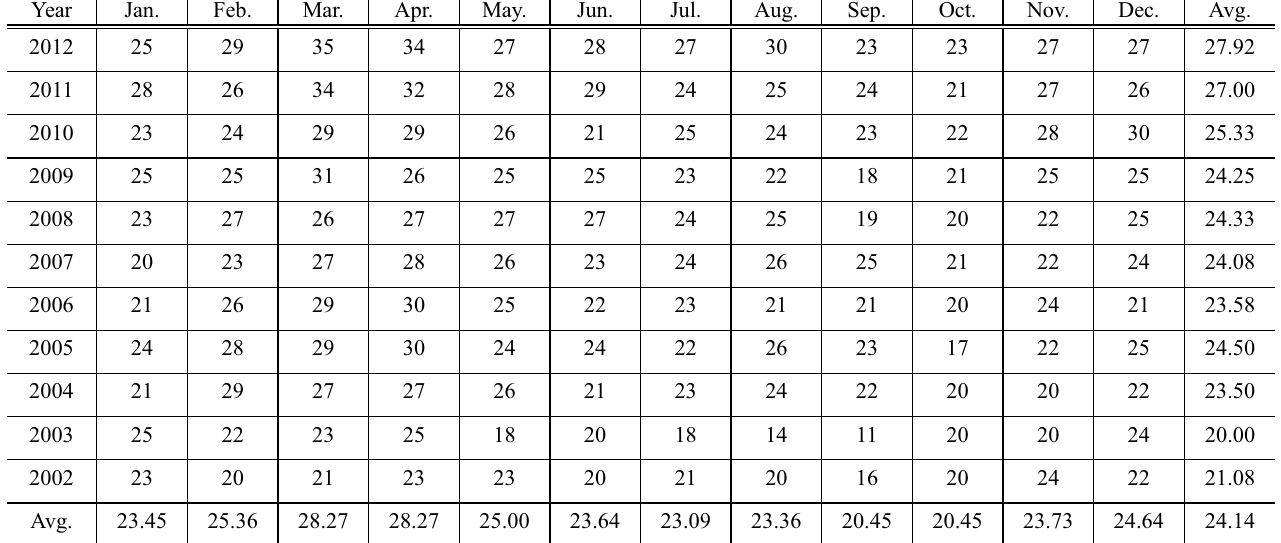
Table 2 Monthly mean wind speed at Seoul, Korea (0.1 m/s).